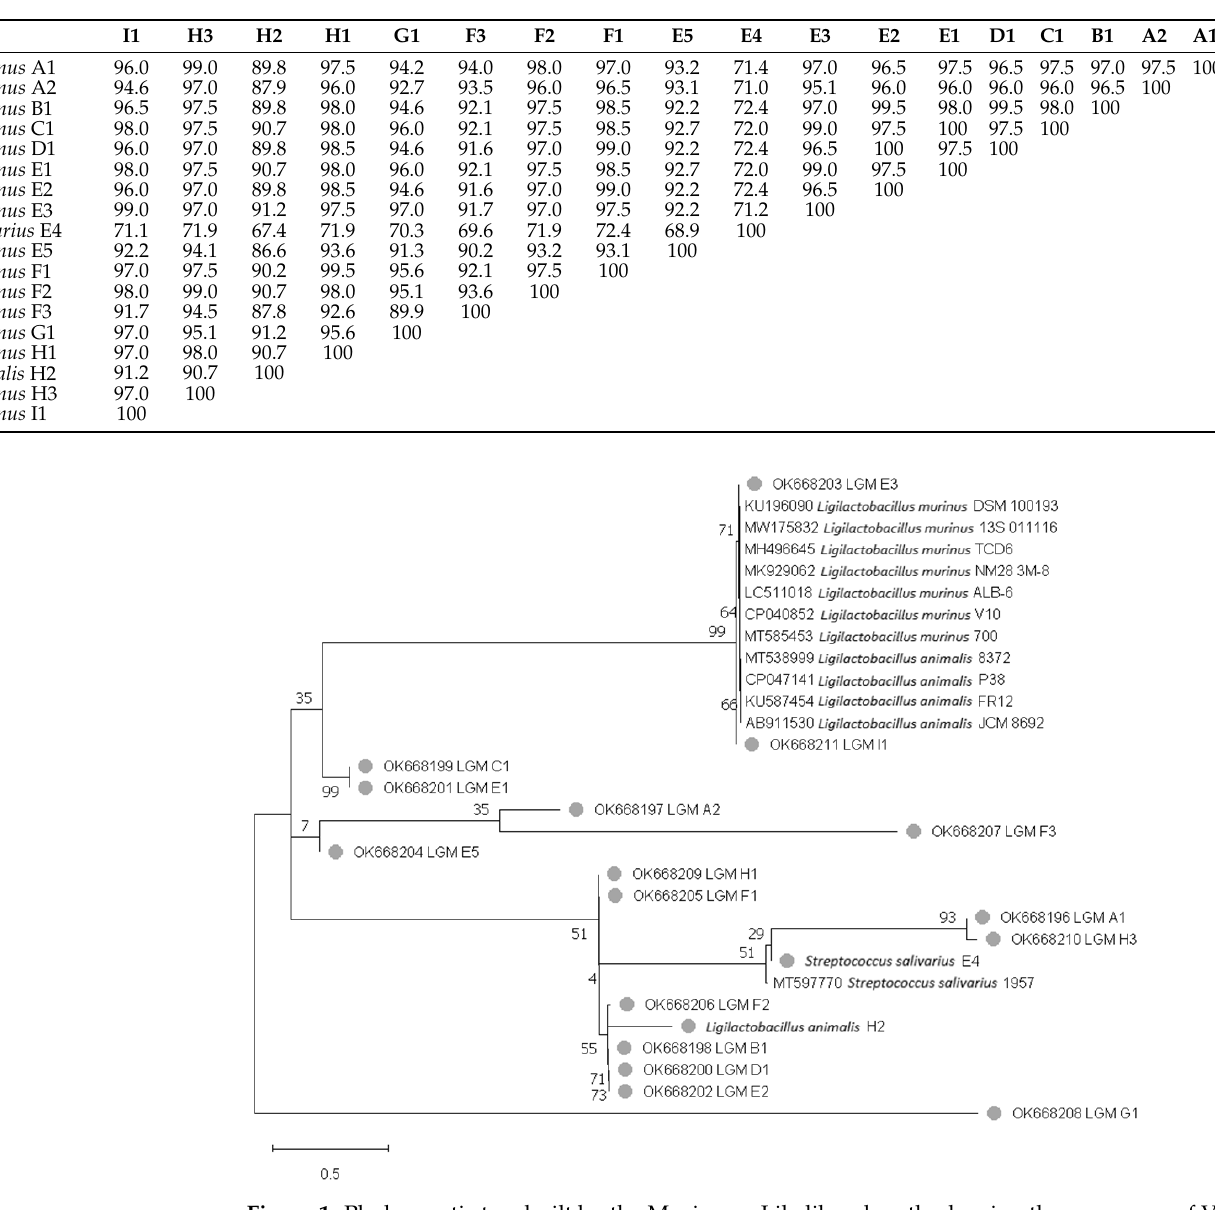
Table 3. Kinetic parameters of the isolated LAB strains. Data are expressed as a mean and standard deviation. abcdef shows a signi fi cant di ff erence per column (Tukey). Isolated LAB